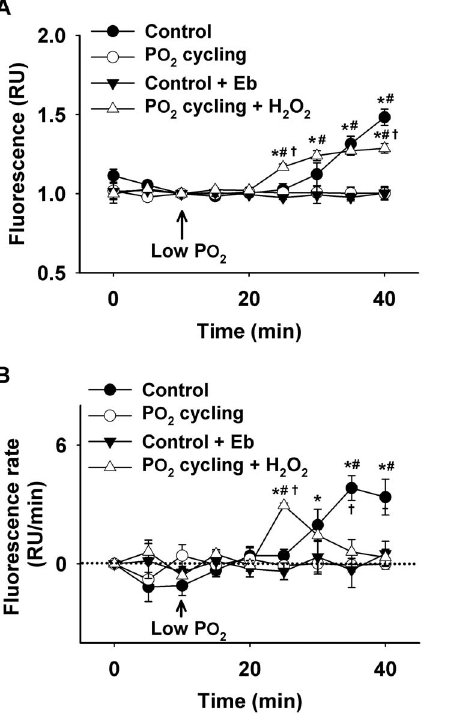
Figure 2. Intracellular ROS fluorescence and fluorescence rate under 40 Torr PO 2 . A: averaged fluorescence data recorded in a relative unit (RU). Data showed intracellular ROS levels from control, PO 2 cycling, ebselen (Eb), and PO 2 cycling + H 2 O 2 treated diaphragm muscle (*significantly different from PO 2 cycling, P , 0.05; # significantly different from Eb treatment, P , 0.05; { significantly different from control, P , 0.05). B: intracellular ROS burst represented by fluorescence rate. Data was recorded in a relative unit per min (RU/min) from control,